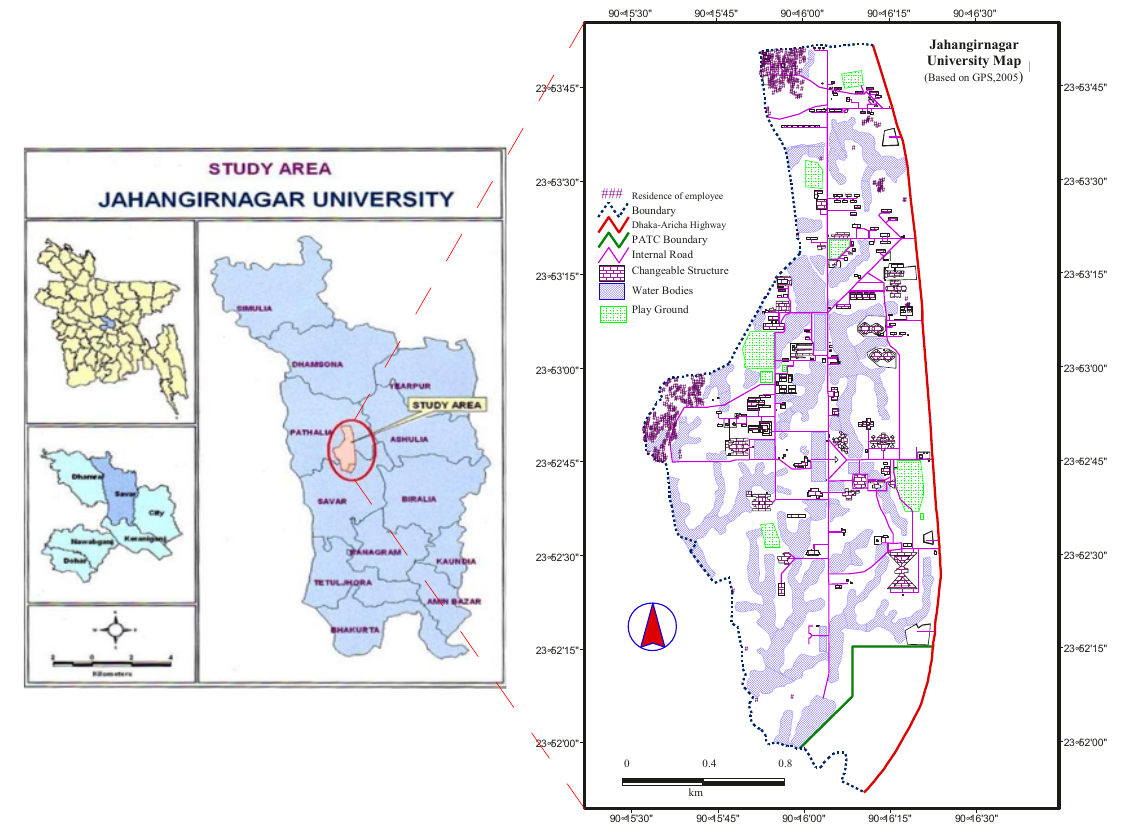
Figure 1. Map of Jahangirnagar University Campus (GIS resource laboratory, Jahangirnagar